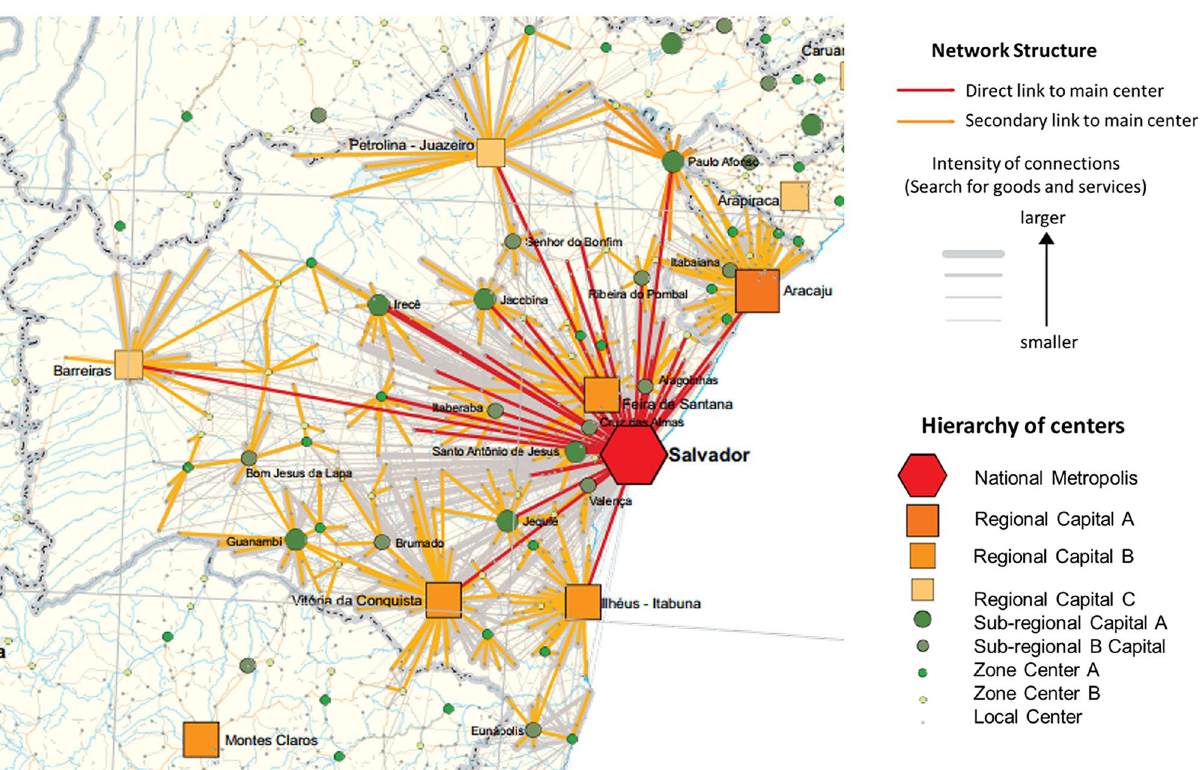
Figure 6. Salvador capital of Bahia, into the RMS is characterized by include intense connections between cities. It plays a role of territorial management, evaluating levels of centrality of the executive and judiciary at the federal level, and of corporate centrality, as well as having different facilities and services. Figure adapted from 13